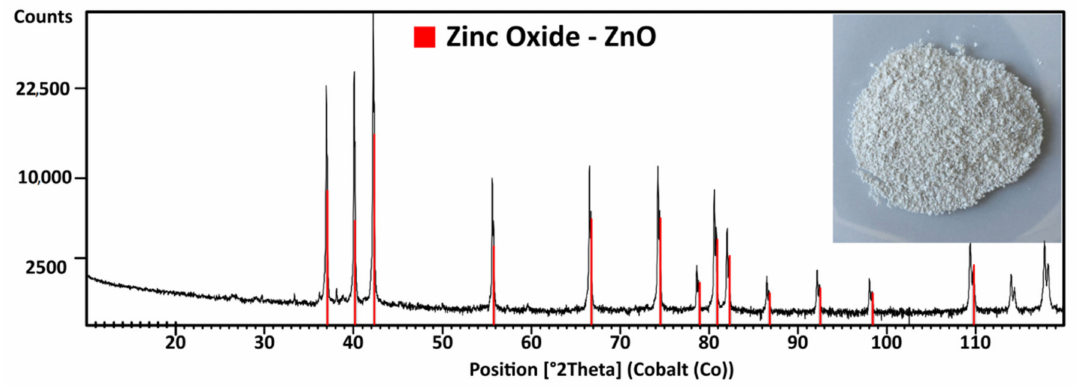
Figure 17. Zinc precipitate after calcination at 900 ◦